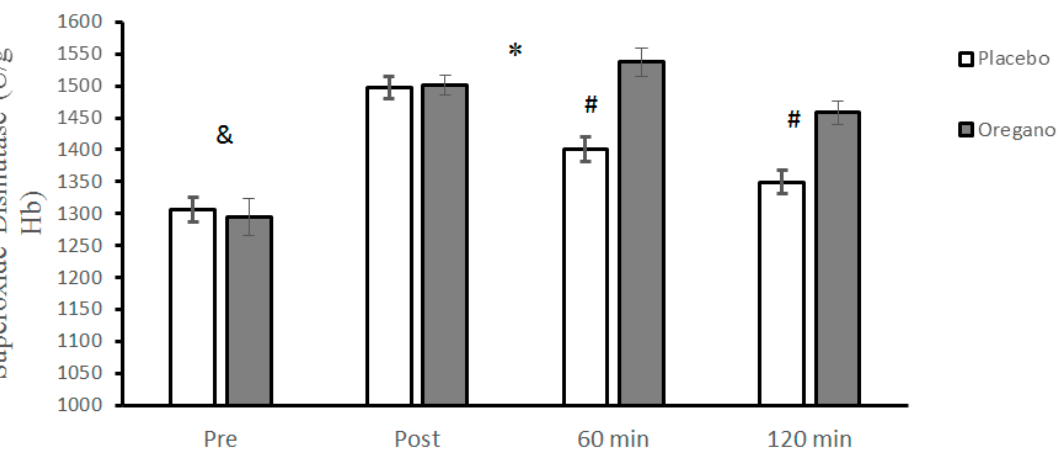
Figure 7. Mean ± standard deviations (SD) of plasma SOD levels before and at different times after consuming oregano supplements. The asterisk (*) indicates significant time × group interaction, (#) indicates a significant difference between the two groups, and (&) indicates the main effect of time ( p < 0.05).